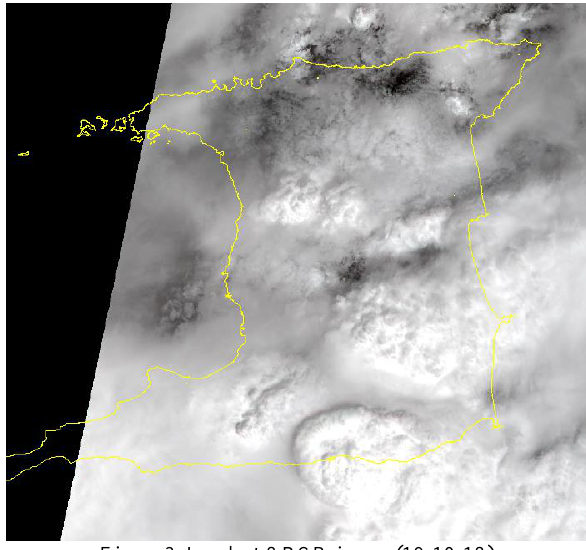
Figure 3. Landsat-8 RGB image